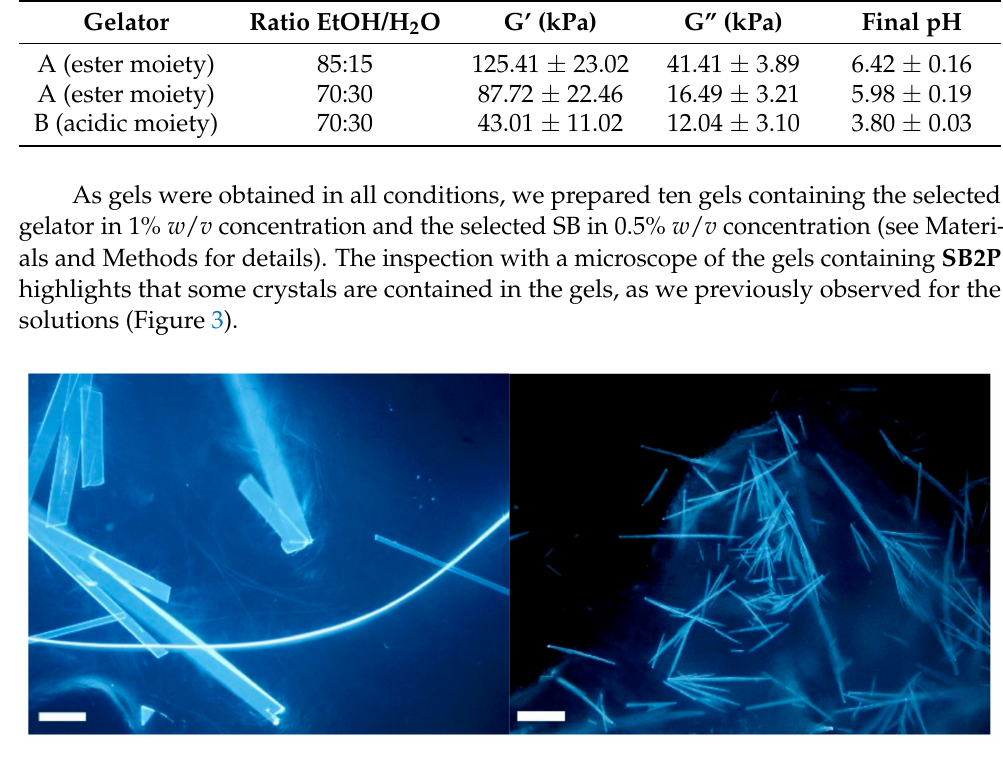
Figure 3. ( left ) Microscope image in epifluorescence mode of a piece of gel A containing SB2P ; ( right ) microscope image in epifluorescence mode of a piece of gel B made with SB2P . Scalebar is 100 µ